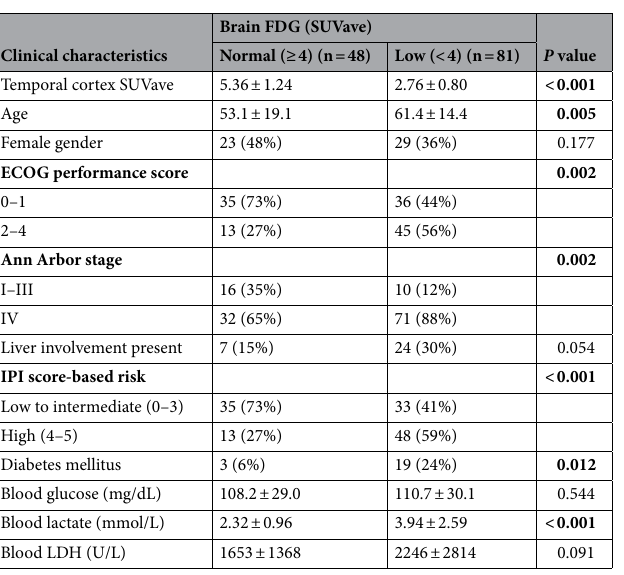
Table 2. Clinical characteristics according to brain FDG uptake. Significant values are in bold. FDG, 18 F-fluorodeoxyglucose; SUVave, average standard uptake value; ECOG , Eastern Cooperative Oncology Group; IPI, International Prognostic Index; LDH, lactate dehydrogenase. Data are represented as means ± standard deviations.